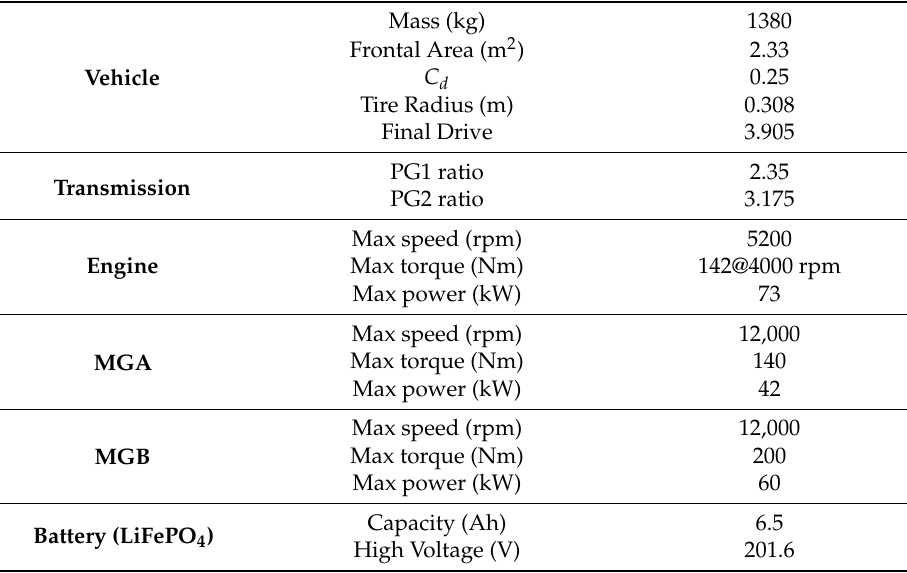
Table 1. Vehicle